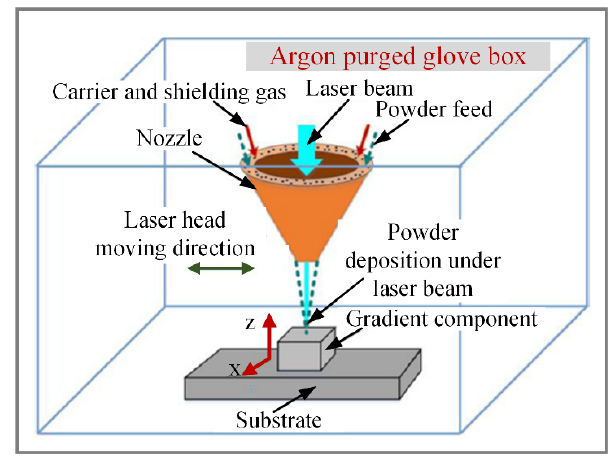
Figure 3. Schematic of the DED process [45].